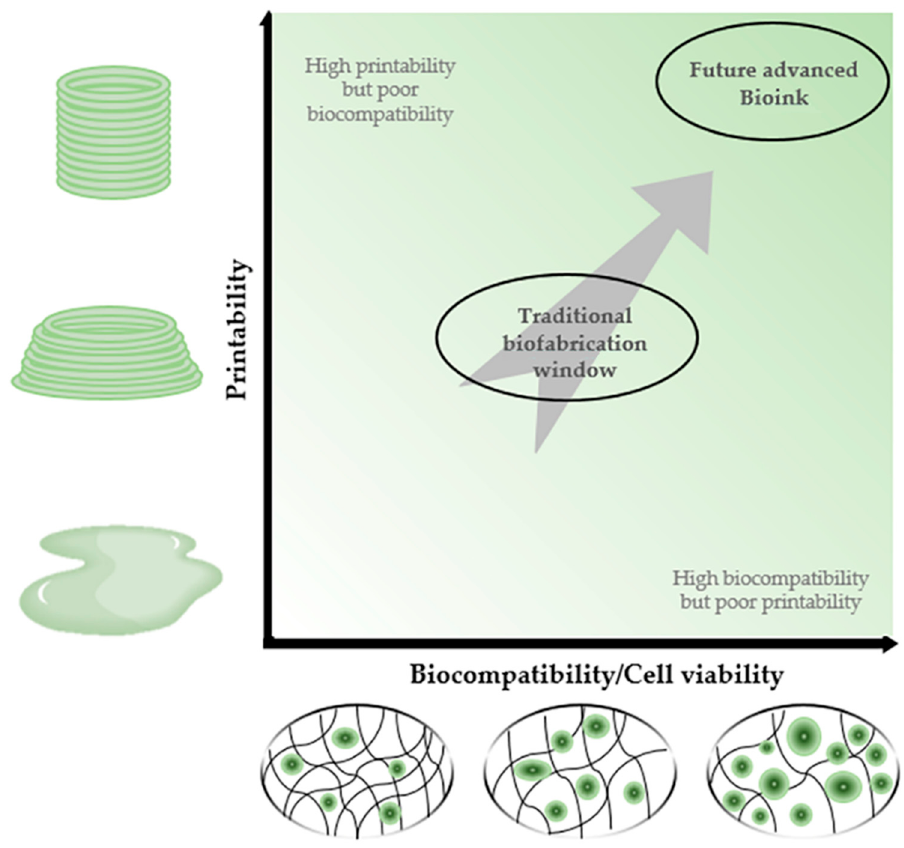
Figure 1. Description of the 3D bioprinting printability/biocompatibility window. Proposed bioink must have properties that satisfy both printability and biocompatibility unlike conventional